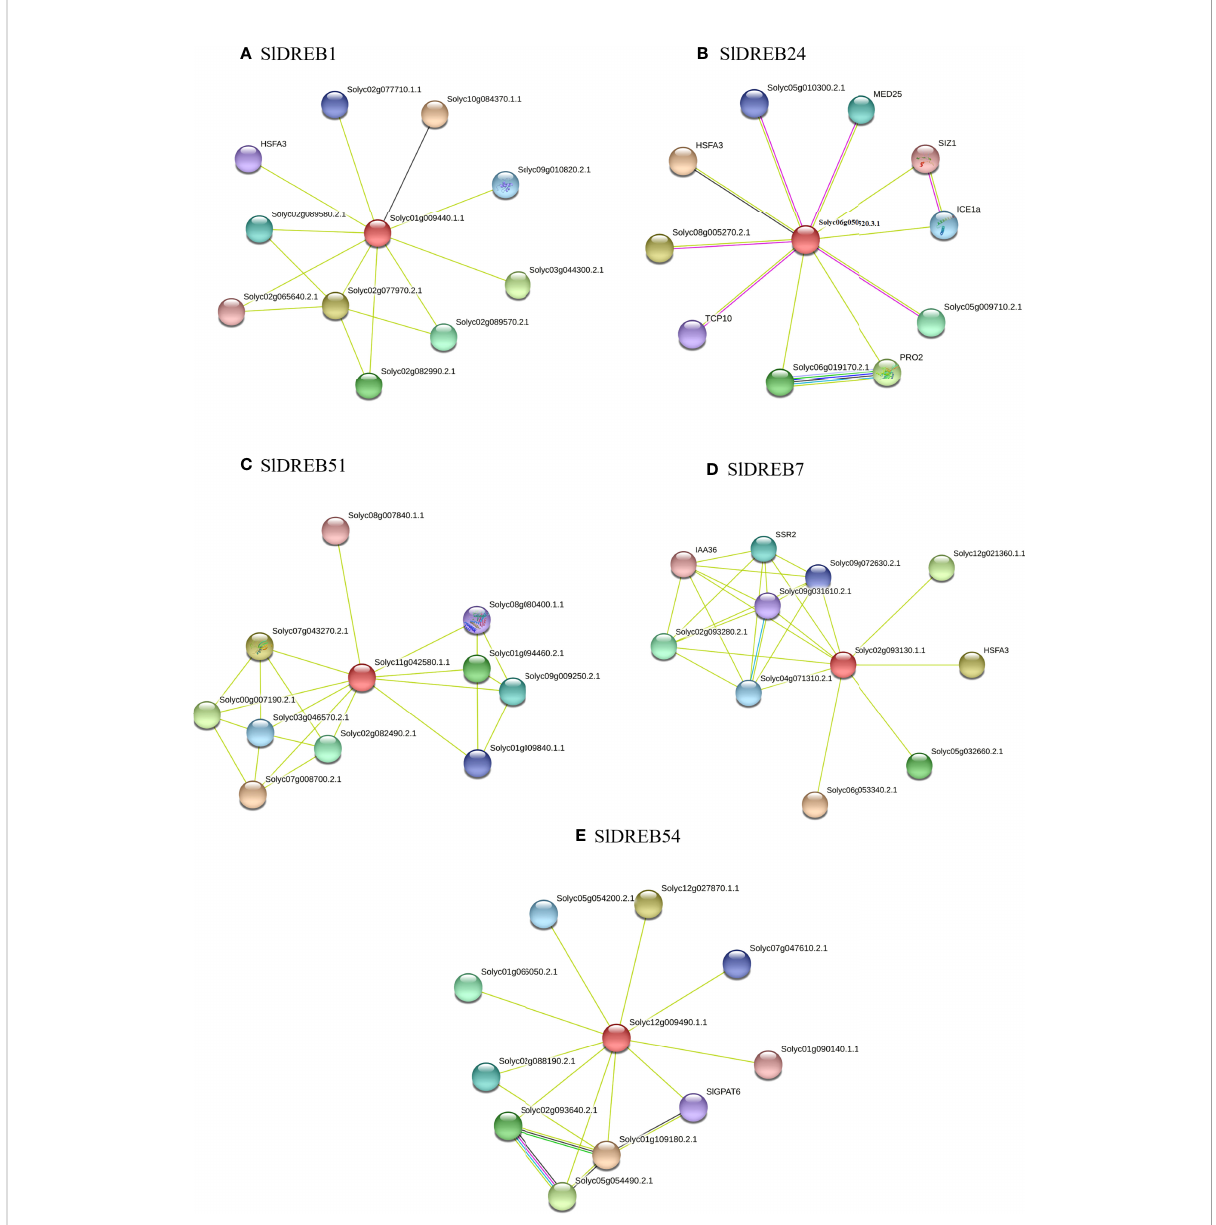
FIGURE 13 Interactive networks of SlDREB proteins through the STRING software. Protein interactions of SlDREB1 belong to A1 class denoted as (A) , SlDREB24 member of A2 as (B) , (C) SlDREB51, (D) SlDREB7, and (E) SlDREB 54 belong to A4, A5, and A6 classes, respectively. Colored networks depicted the associations depending on the information gathered from different databases, i . e ., theoretical knowledge, experimental evidence, closely related genes, and protein model